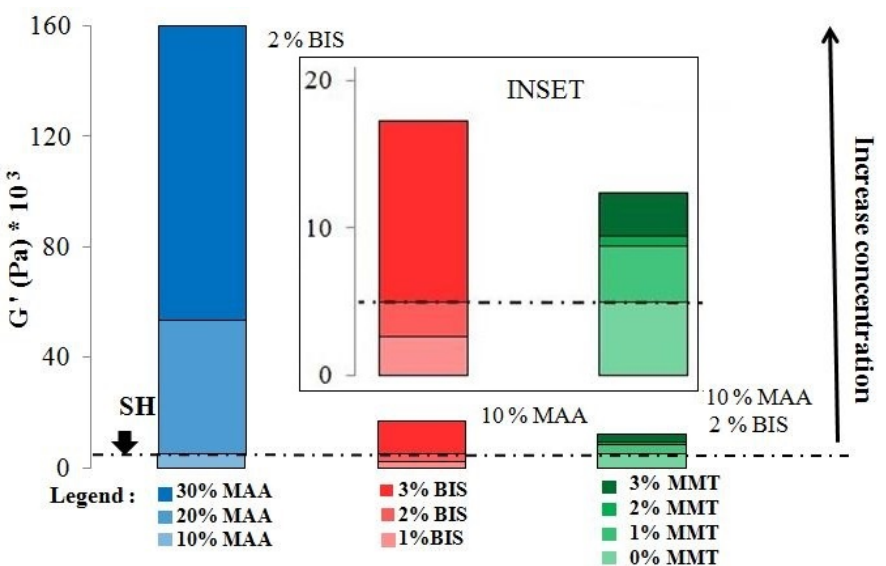
Figure 10. Comparative influence of the monomer, crosslinking agent, and reinforcing agent con- centrations on the viscoelastic properties of PMAA hydrogels. As opposed to the effects of the monomer and crosslinking agent concentrations, the increase in the MMT concentration in the hydrogel resulted in an increase in the swelling degree of the hydrogel at pH 5.4 and 7.4, due to the basic character of the clay, while at pH 1.2, a slight decrease in water absorption was noticed, ascribable to a slight crosslinking effect of the MMT, in agreement with the rheological